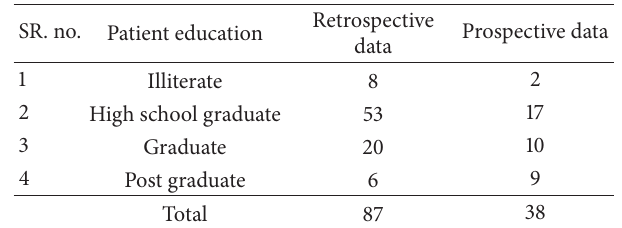
Table 2: Socioeconomic classification of dementia cases.